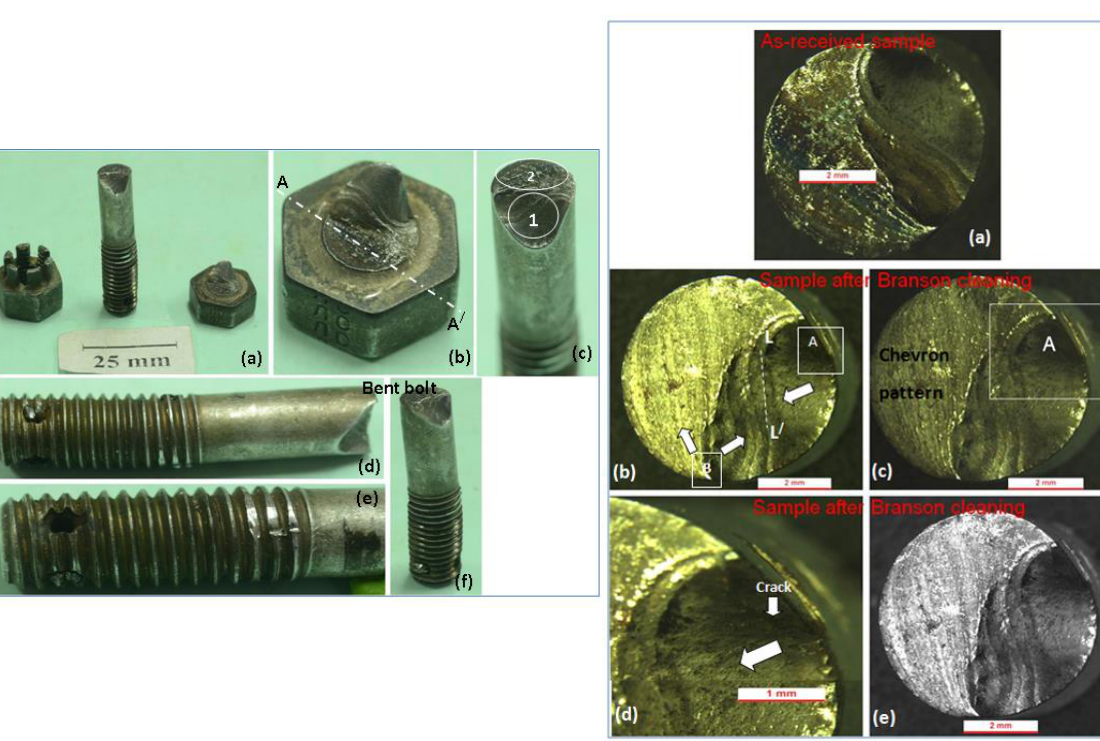
shank part in various illuminating and cleaning conditions: (a) acetone and (b-e) Branson cleaned